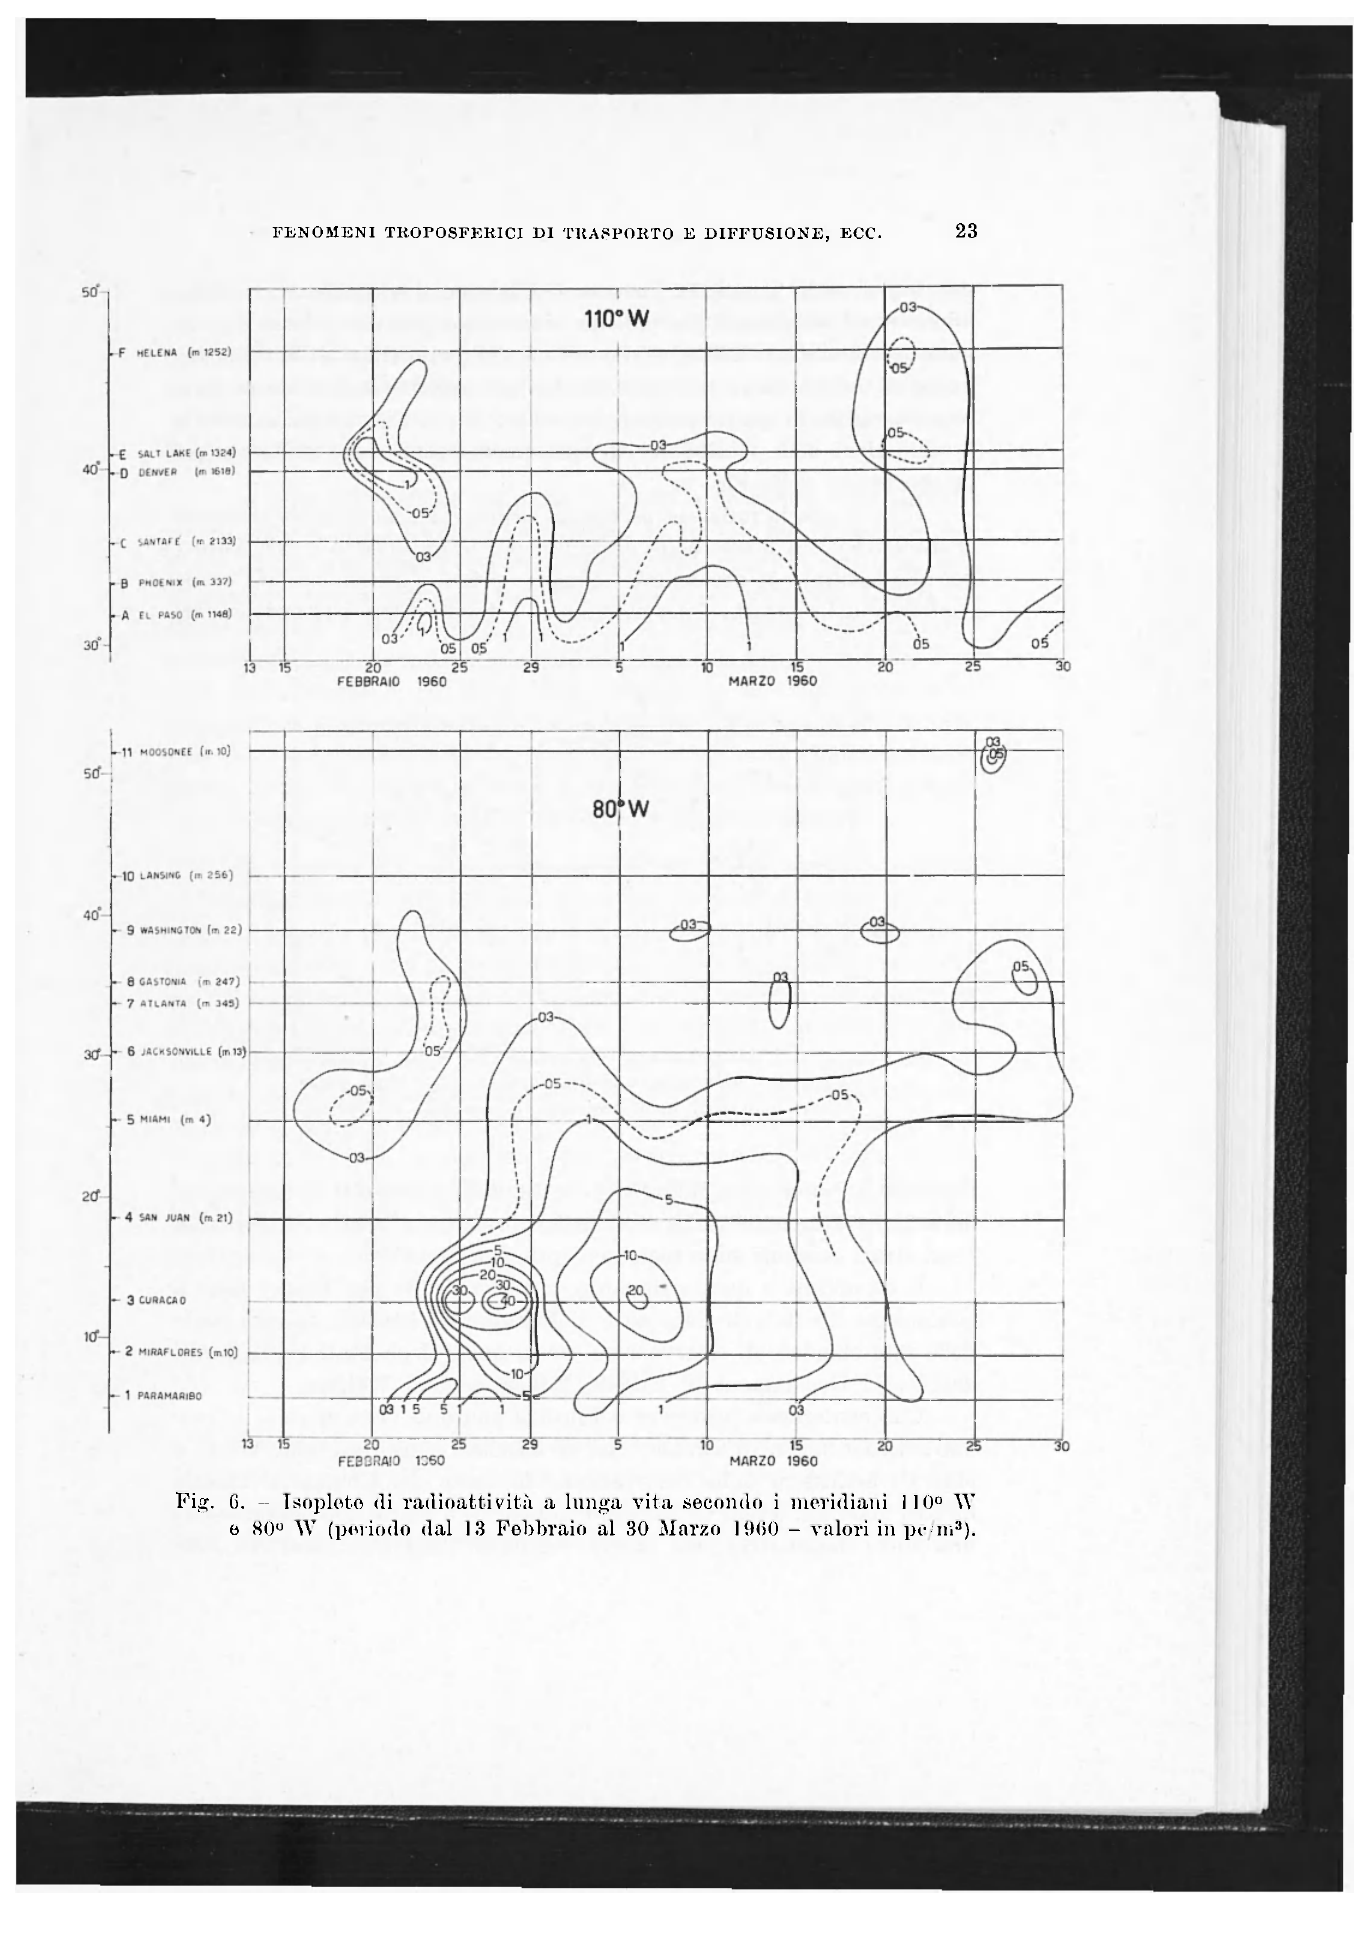
Fig. 6. - Tsoplete di radioattività a lunga vita secondo i meridiani I 10°